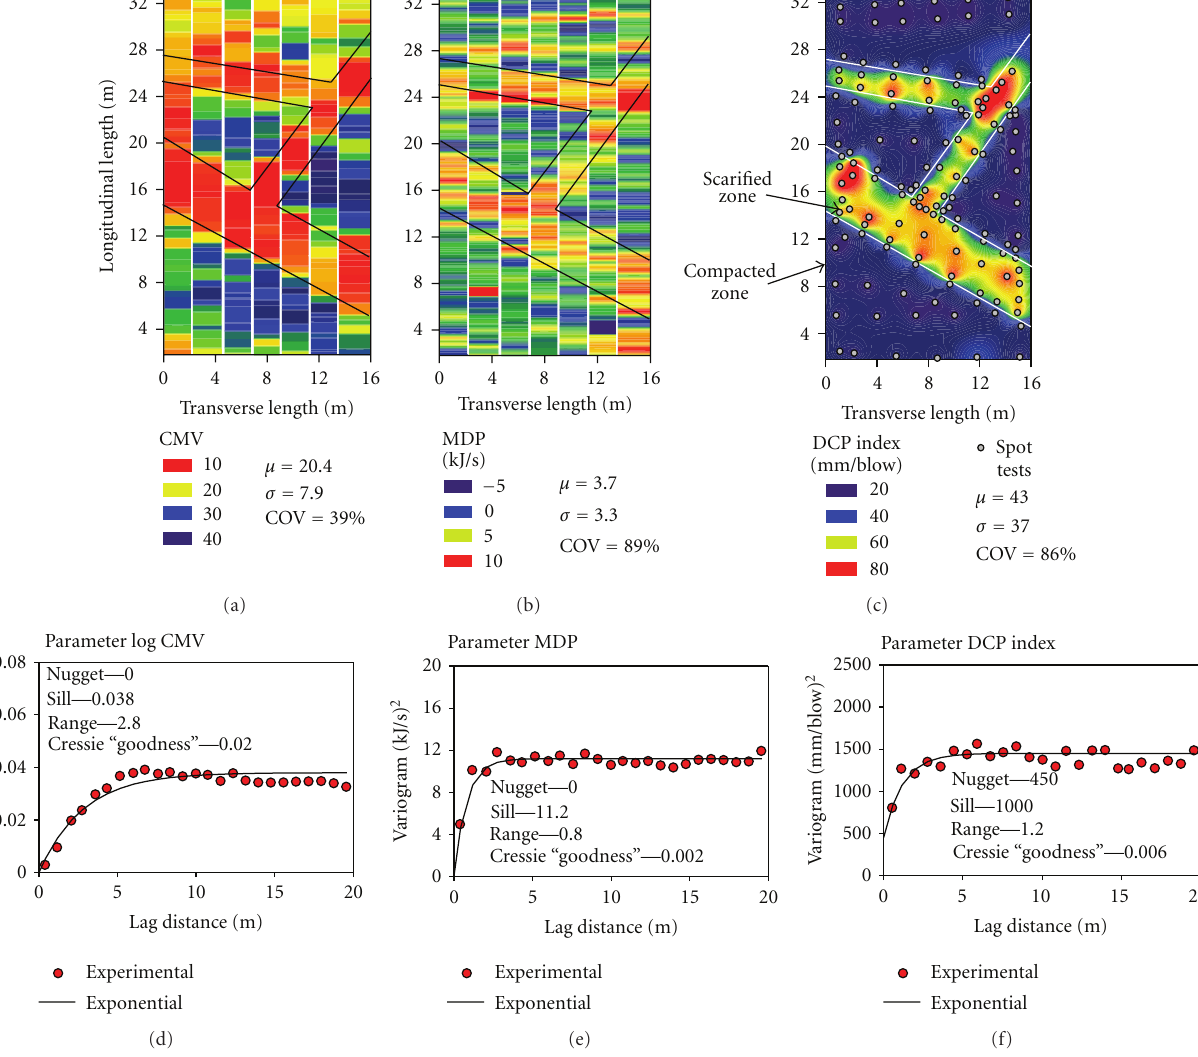
Figure 6: Spatial comparison of dynamic cone penetration (DCP) index and roller-integrated CMV and MDP measurements on compacted and scarified Edwards glacial till subgrade